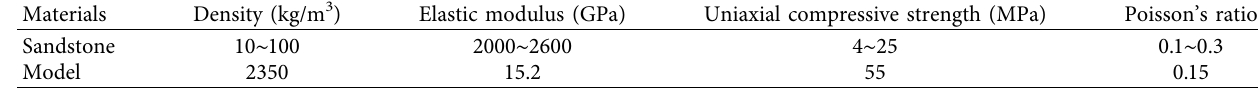
Figure 12: Sketch diagram of specimen dimensions. Table 4: Mechanical properties of sandstone and specimens.